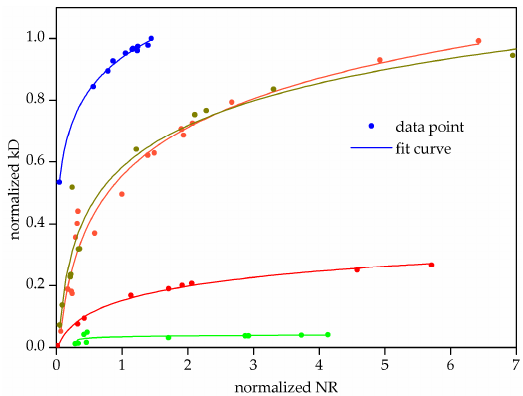
Figure 10. Relationships between NR (NDVI-reflectance) and normalized kD (difference between slopes of actual NDVI isoline and simulated k value isoline).